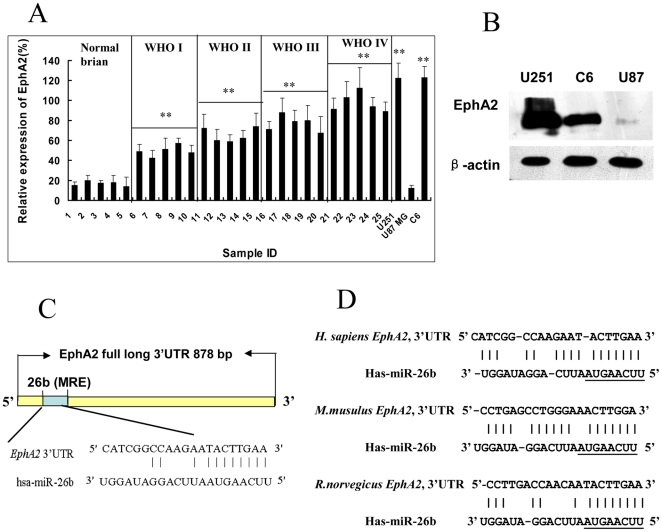
EphA2 is a predicted target of miR-26b.(A) The mRNA expression level of EphA2 in glioma samples and glioma cell lines. The mRNA expression level of EphA2 was detected by real-time PCR. The grades of glioma were classified in Materials and Methods. The experiments were preformed more then three times. The relative expression of EphA2 was the ratio of the expression level of to that of β-actin. **P<0.01, as compared to Normal brain tissues group. (B) The protein expression level of EphA2 in U251, U87 MG and C6 cells. Western blotting analysis was performed to evaluate the expression level of EphA2 in different glioma cells. β-actin was used as a loading control. (C) The shaded region represents the MRE sequences of miR-26b in the 3′UTR of human EphA2 mRNA as predicted by TargetScan 5.1, miRBase and Pictar. (D) The predicted miR-26b binding site in EphA2 3′UTR is highly conserved in mammals. The miR-26b seed sequences and their predicted binding sites in the EphA2 3′UTR are shown underlined.